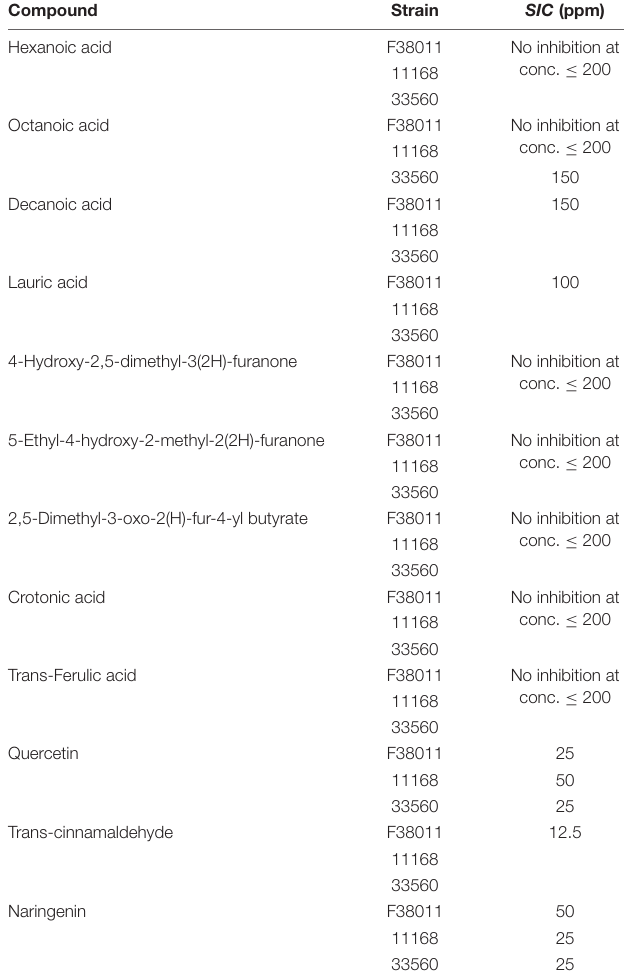
TABLE 2 | The highest subinhibitory concentrations of the selected compounds against three C. jejuni isolates.